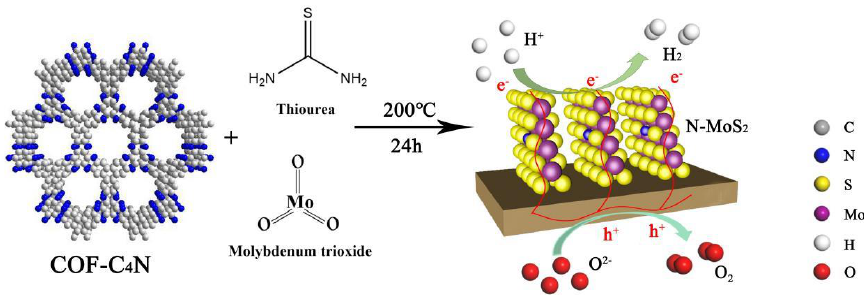
Figure 1. Schematic illustration of synthesis route to vertical N-MoS 2 /COF-C 4 N for both HER and OER.